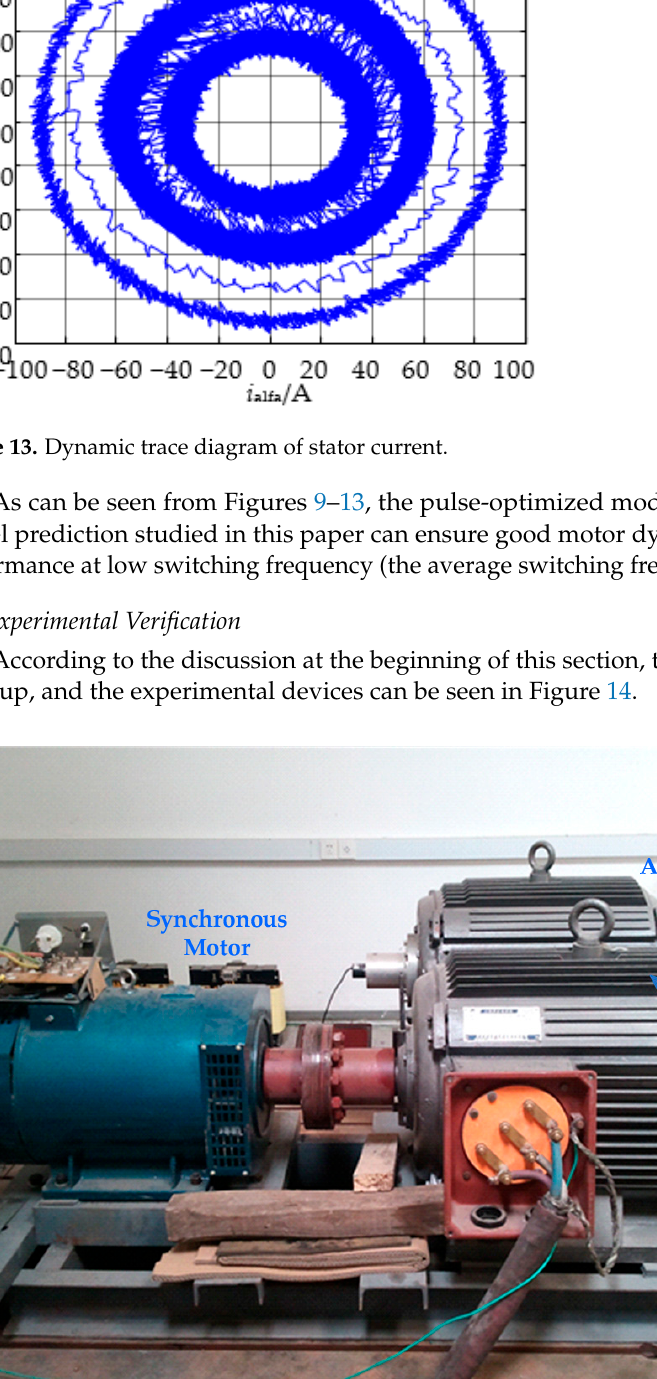
Figure 14. Photo of experimental devices.